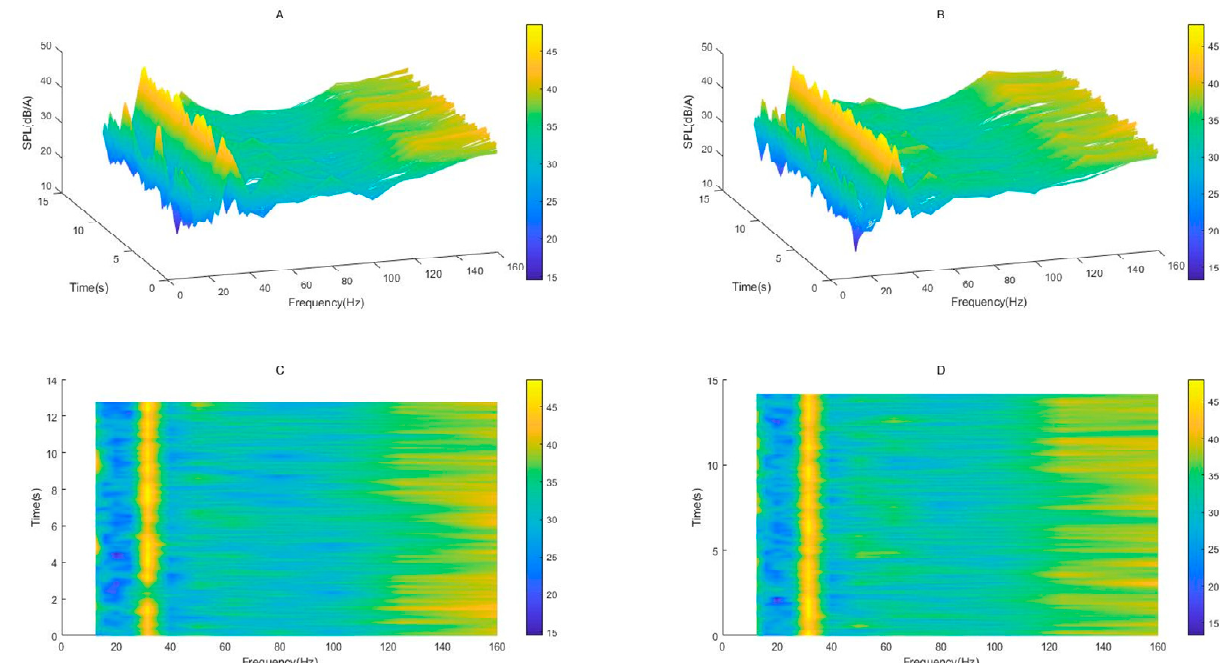
Figure 13. ( A ) Change in SPL and time within 0 to 160 Hz before noise reduction, ( B ) change in SPL and time within 0 to 160 Hz after noise reduction, ( C ) time frequency (0–160 Hz) diagram before noise reduction, ( D ) time frequency (0–160 Hz) diagram after noise reduction.